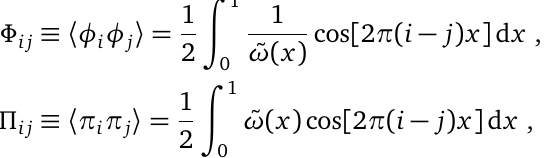
Figure 1: Utilizing the assumption N → ∞ , we fixed N vacuum EE S as a function of z . We fitted the data using (2.11) with c A = 2.080 for the N = 70 case, as determined by Mathematica to be the best fit. We expect that and c A 0 the two values of c should be the same, and the fit should become exact in the massless continuum 0 → ∞ limit J → 0 and N A